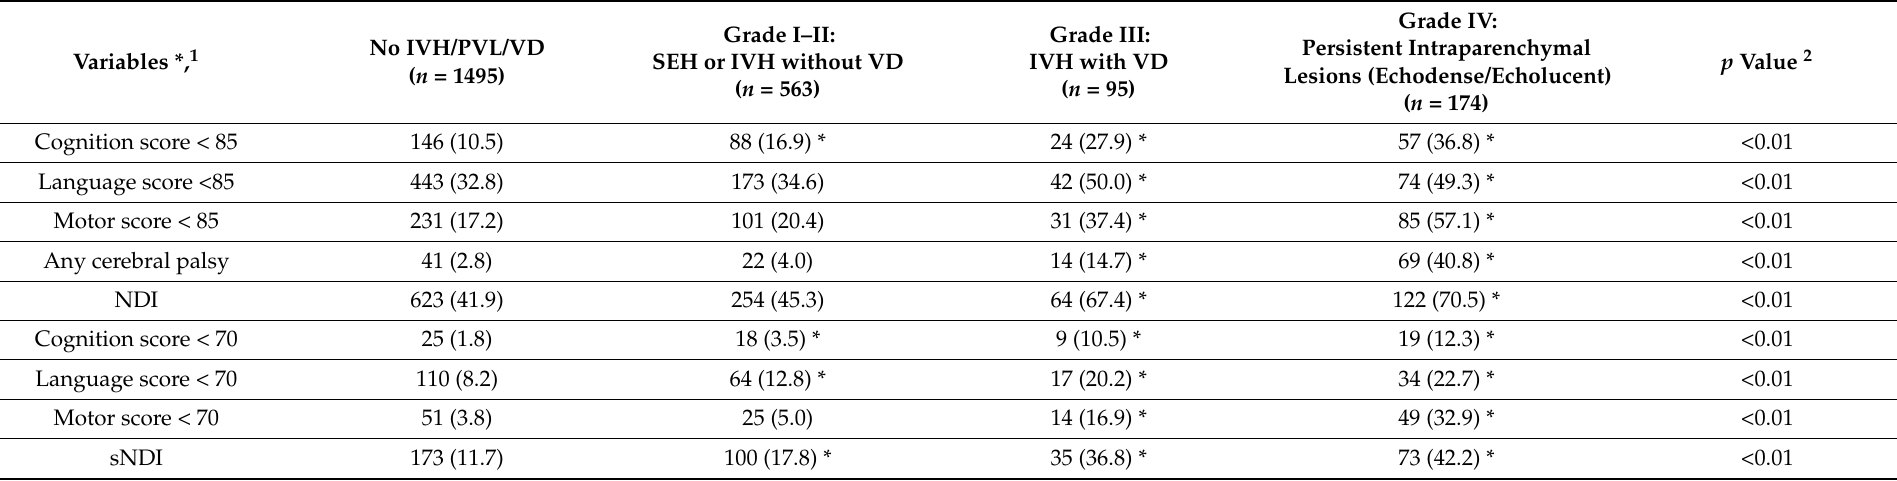
Table 2. Comparison of individual components and composite of neurodevelopmental outcomes among IVH